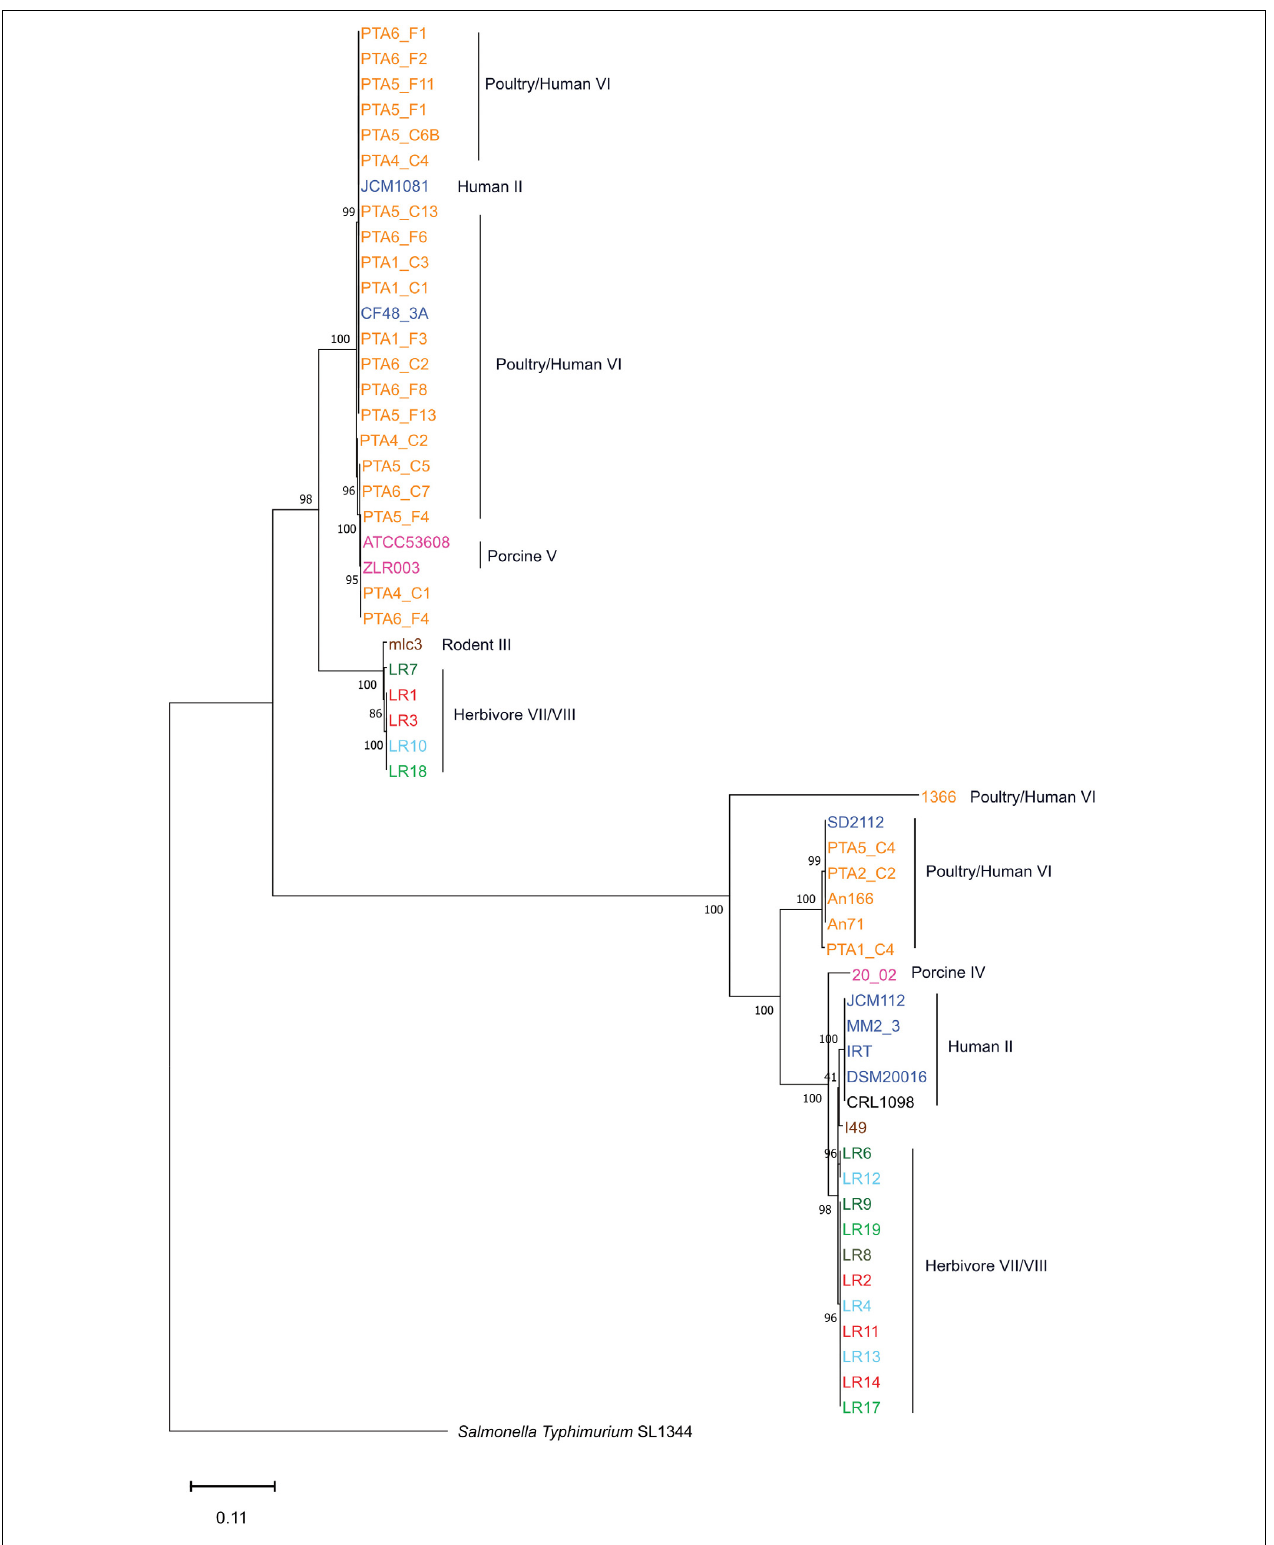
FIGURE 6 | Gene tree based on the nucleotide sequence of concatenated pduA , pduB , pduC , pduD , pduE genes of L. reuteri reuterin-positive genomes of this study (Neighbor Joining Method). Different color represents different hosts, blue: human; yellow: chicken; pink: pig; brown: mouse/rat; light blue: cow; red: goat; green: horse; brown/green: sheep; black: sourdough.